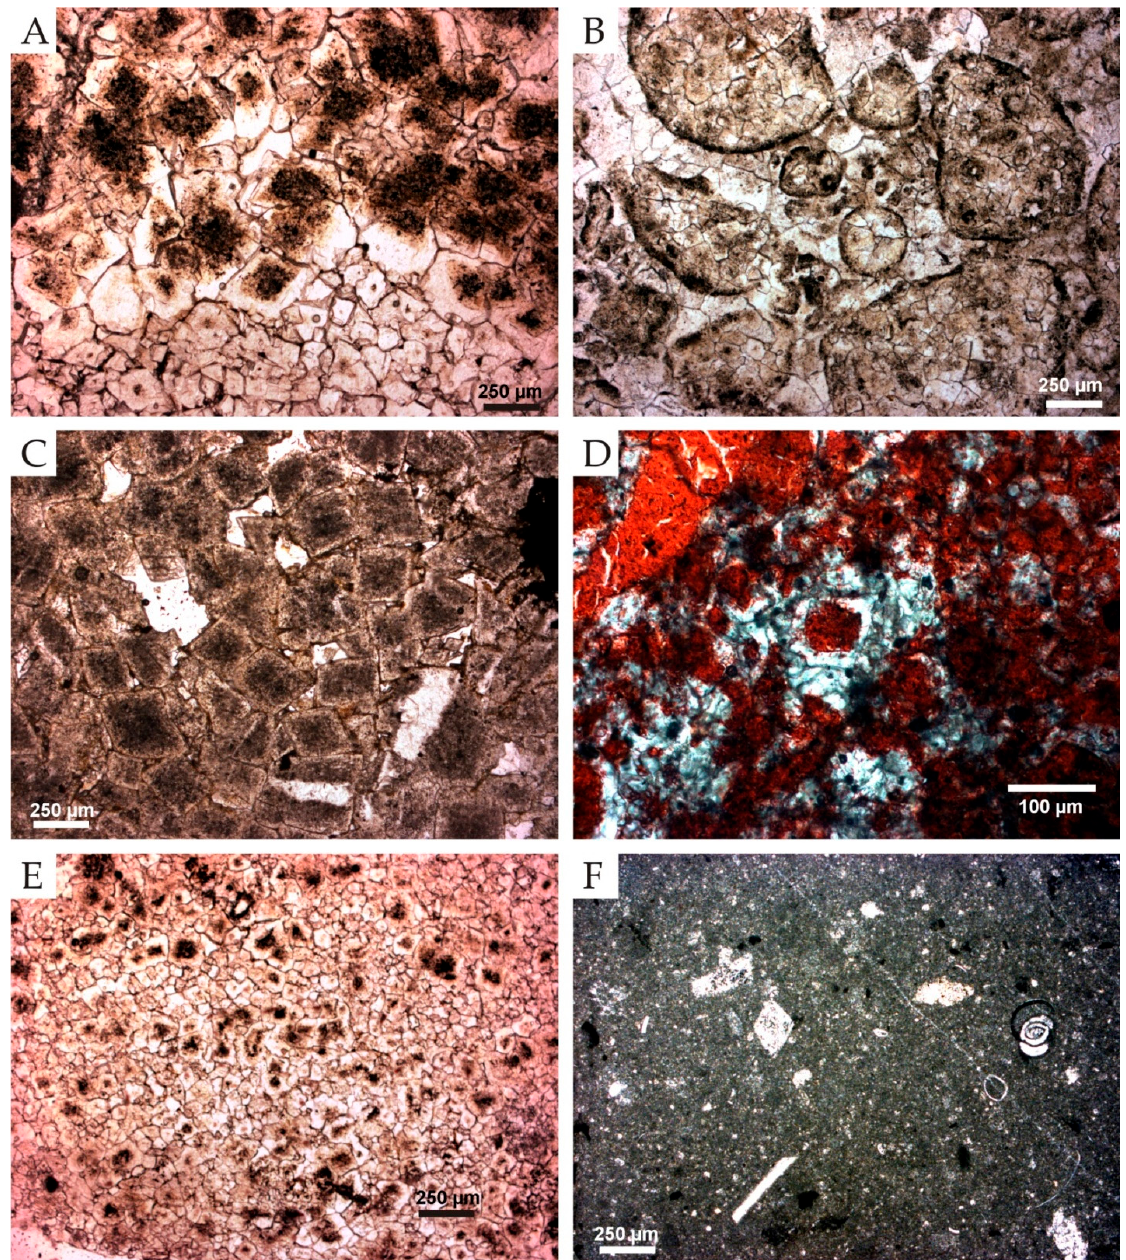
Figure 4. Dolomitic textural types and their distribution by sections. ( A , B ) Mesocrystalline dolosparites. Medium- to coarsely-crystalline dolosparites composed of hypidiotopic (planar-s) mosaics with crystals rich in impurities, often showing zoned and emphasised nuclei ( A ). Ghost of allochems and venules ( B ) are also recognised, as well as mimetic and non-mimetic dedolomitisation textures. ( C , D ) Rhombic dolosparites. Medium- to coarsely-crystalline dolosparites composed of idiotopic (planar-e) mosaics with rhombic crystals rich in impurities. Often these rhombic and subrhombic dolomite crystals are zoned, have internal holes, or are dedolomitised ( D ). Mimetic and non-mimetic dedolomitisation textures are present ( D ). ( E ) Microscrystalline dolosparites. Finely-crystalline dolosparites composed of unimodal (20–150 μ m) hypidiotopic mosaics with subhedral to anhedral (plana-s) crystals. Generally, the thickest crystals show impurity-rich internal areas. ( F ) Dolomicrites composed of crypto-microcrystalline (4–20 μ m) hypidiotopic mosaics with disperse subrhombic dolomite crystals. Non-mimetic dedolomitisation textures are present. ( A ) (JUM section); ( B , C , E ) (Y section); ( D ) (SP section); ( F ) (JIM section).